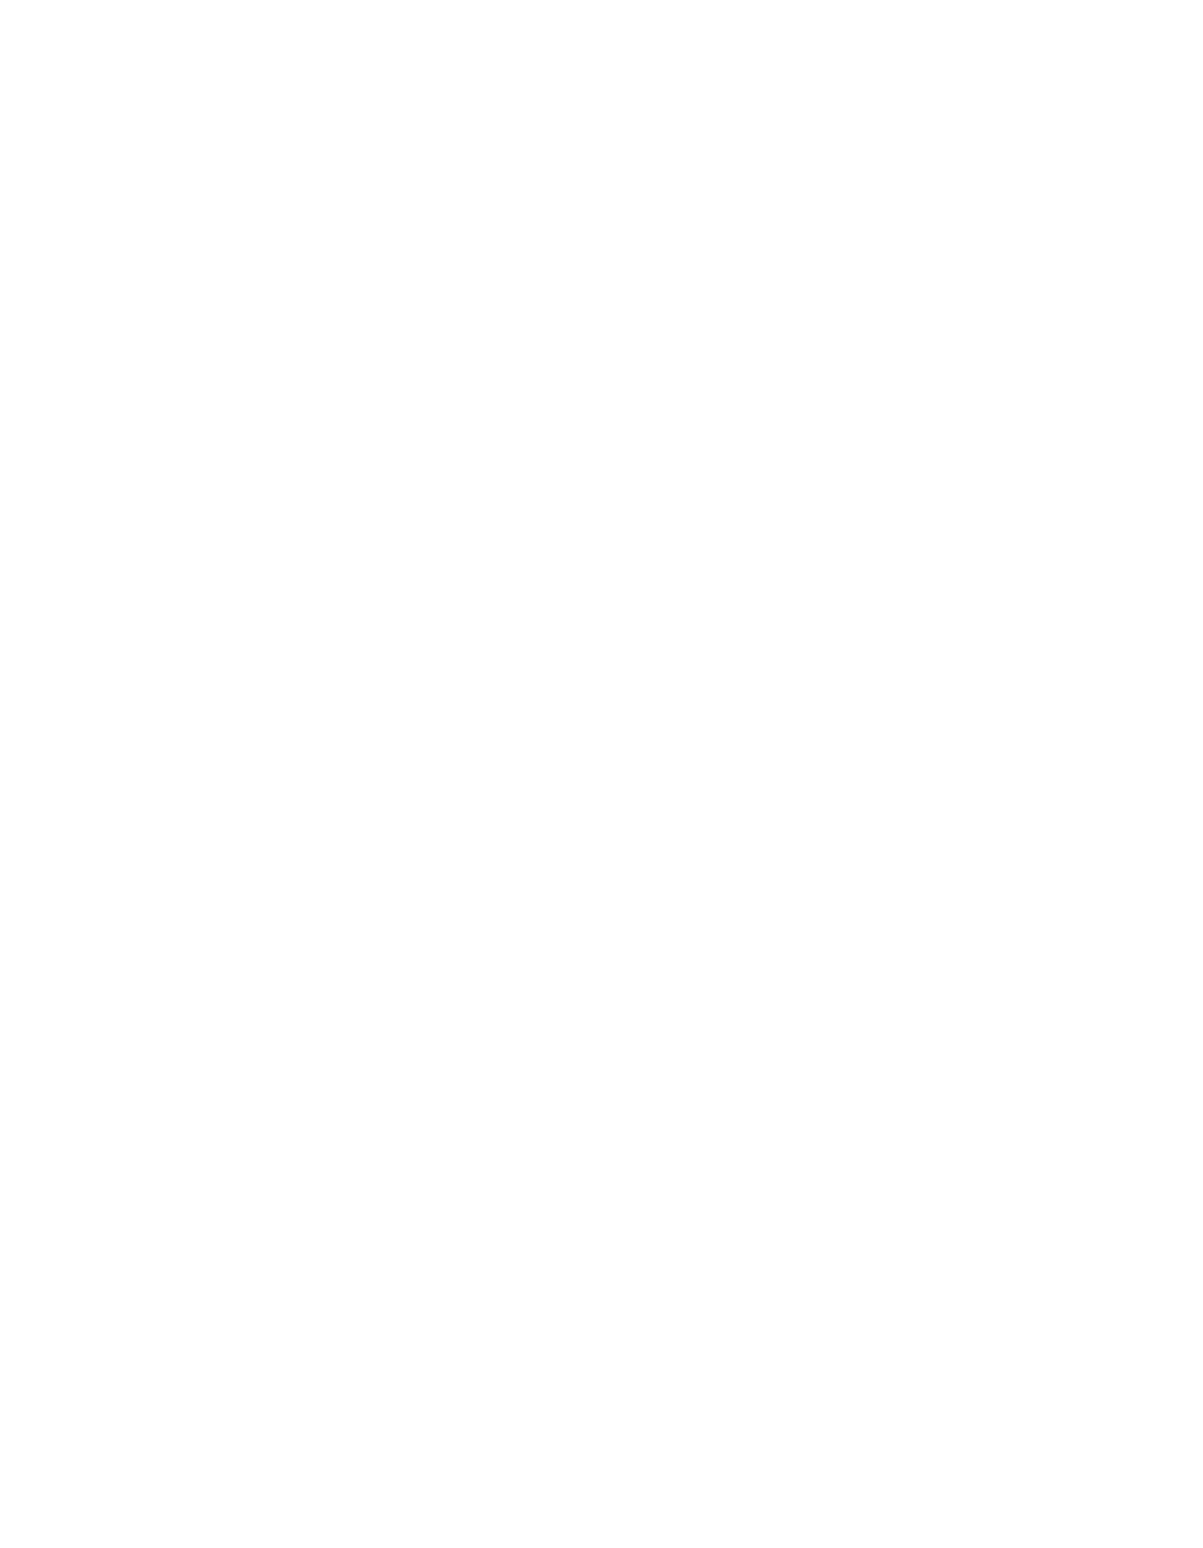
Figure 9. Eudactylopus fasciatus Sewell, 1940, male. A, P2; B, copepodid stages (C IV) - A1; C, C IV - Ur; D, C IV - P1; E, C IV-P2; F, C IV - P3; G, C IV - P4; H, C IV - P5. Scale bars: 100